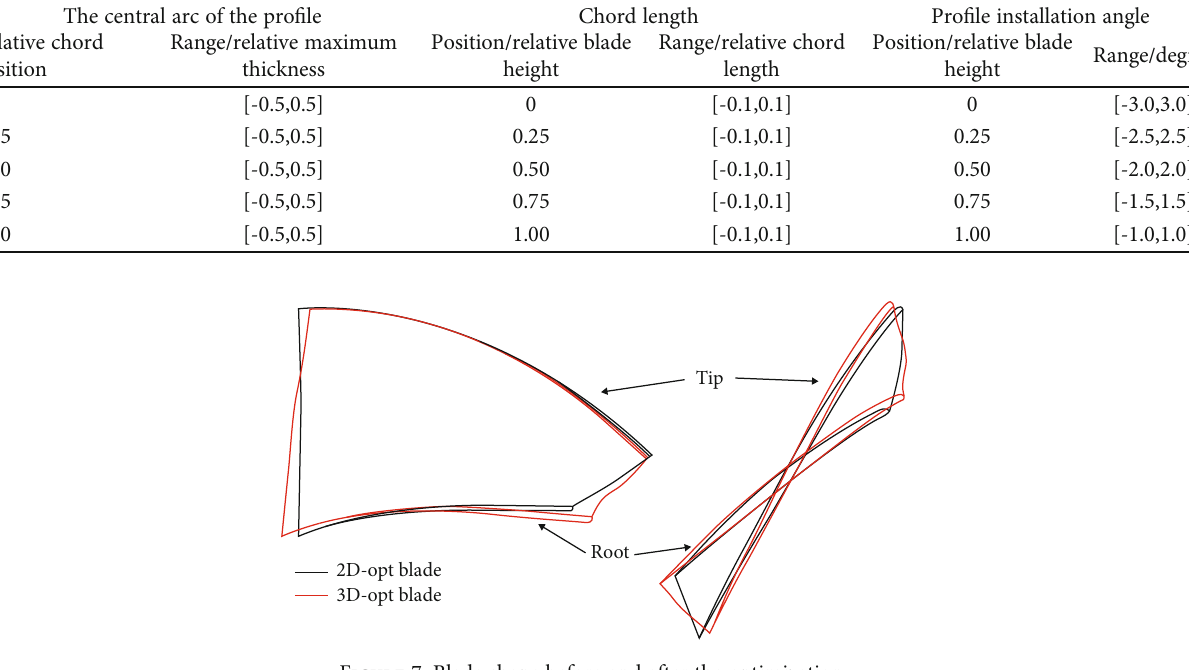
Table 4: Variable position and range for 3D blade optimizations.